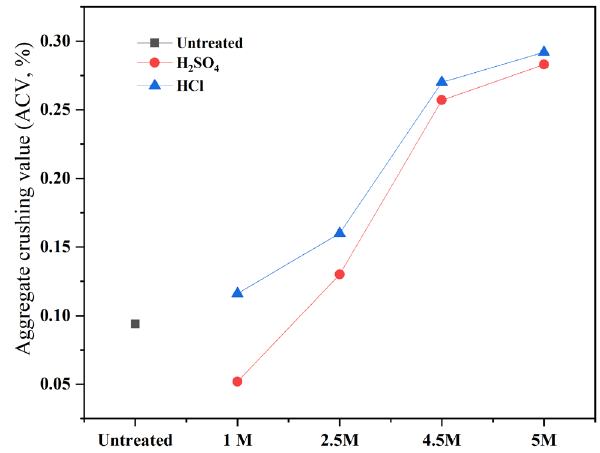
Figure 10. Aggregate crushing value of various RCA samples.